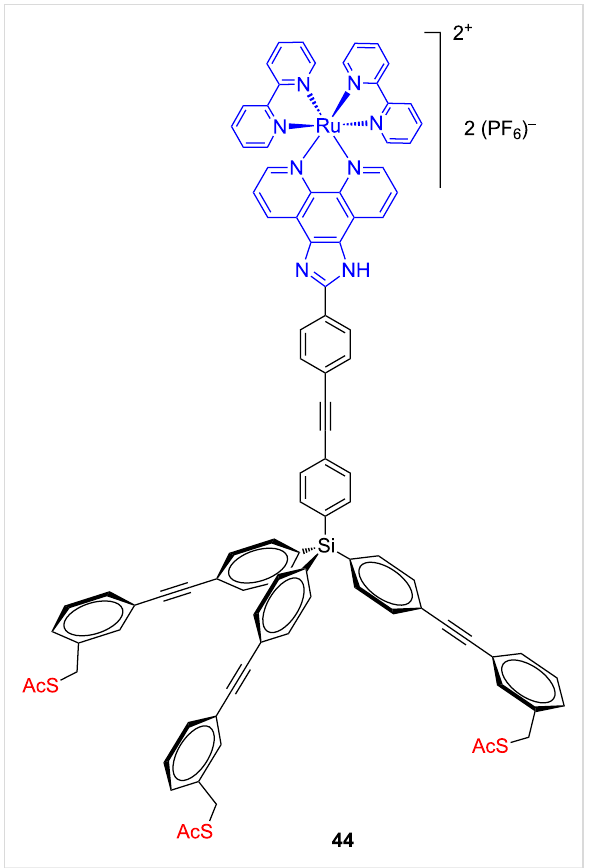
Figure 22: Structure of the tripodal luminescent ruthenium complex 44 .